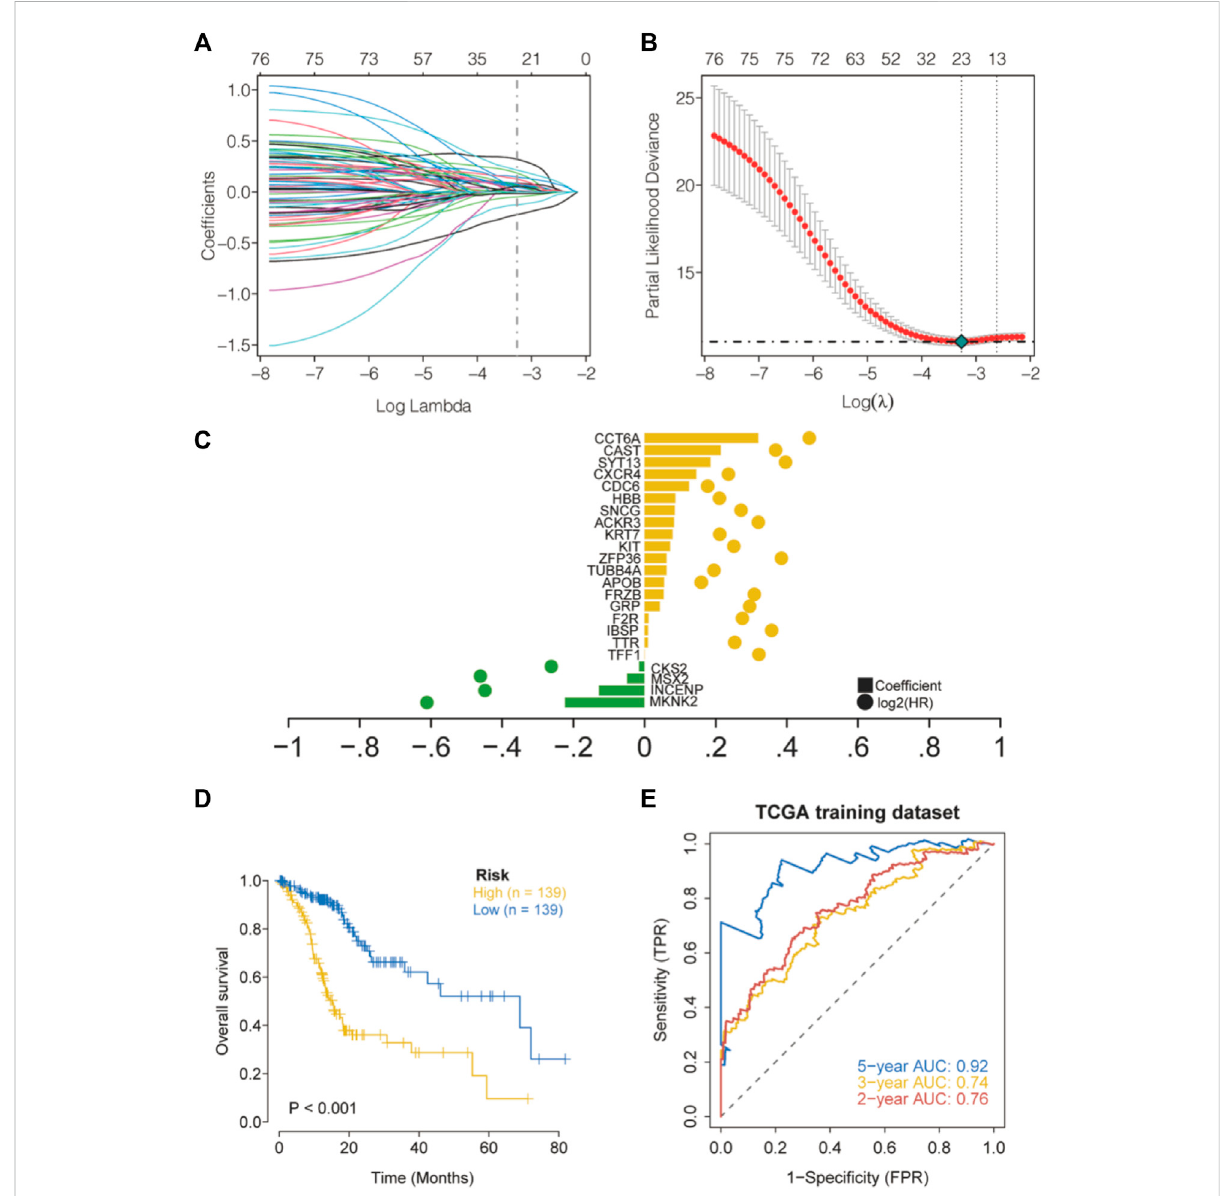
FIGURE 4 Construction of apoptosis risk scores in the cohort TCGA-STAD. (A) LASSO coef fi cient curves for 77 prognostic apoptotic genes in the training setTCGA-STAD. (B) Thecoef fi cientpro fi leplotwasgeneratedwithlog( λ ). (C) Theregressioncoef fi cientsandlog2(HR)for23genesassociatedwith apoptosis. (D) Kaplan – Meier curves for high- and low-risk groups. (E) Validation of ROC curves for the apoptosis risk score in the training dataset from